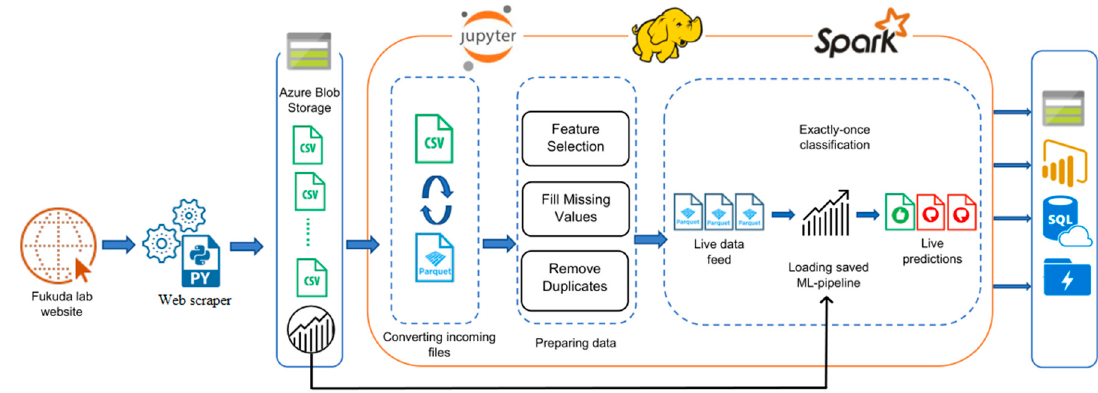
Figure 3. Diagram of proposed approach.